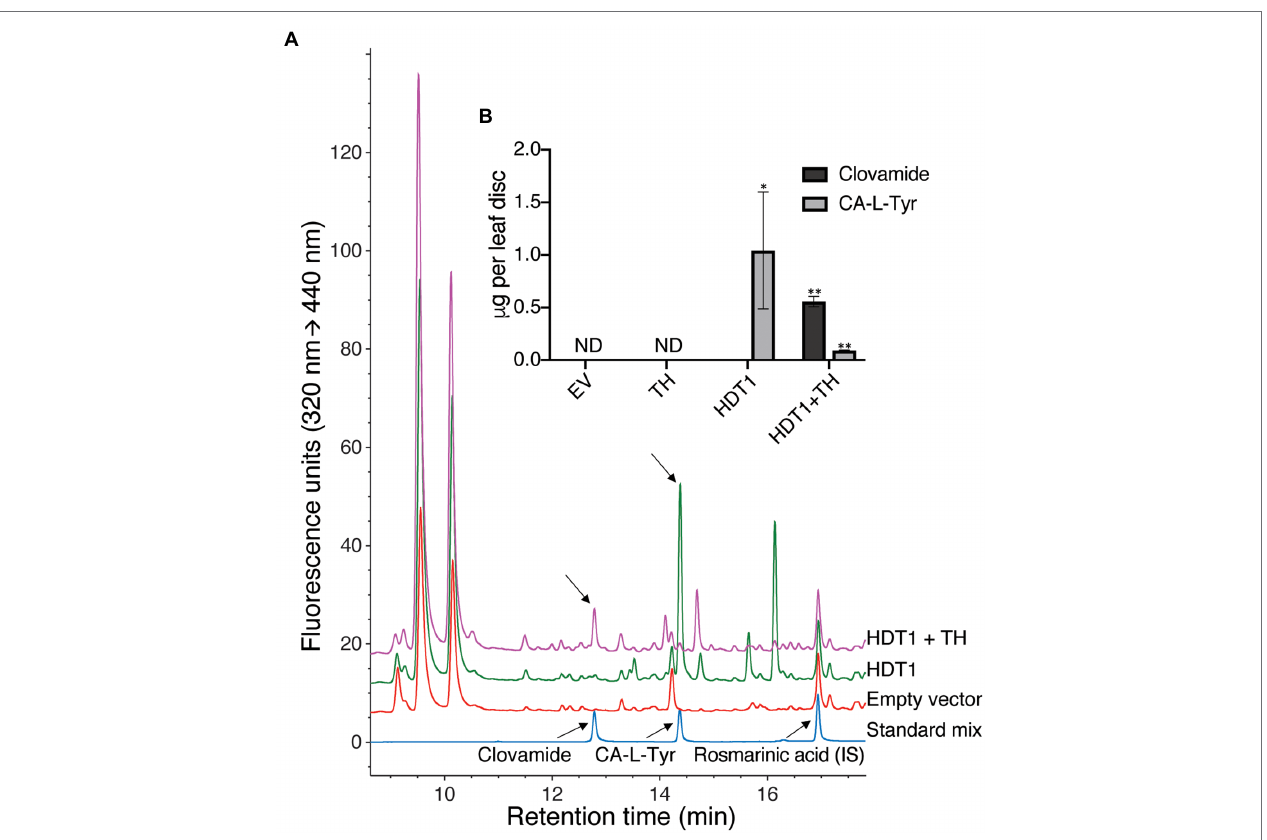
FIGURE 6 | Formation of clovamide in Nicotiana benthamiana leaf by A. tumefaciens- mediated transient coexpression of HDT1 with beet tyrosine hydroxylase (TH, CYP76AD6). (A) HPLC-FLD chromatograms of N. benthamiana extracts and standards (IS, internal standard). (B) Clovamide and caffeoyl-L - tyrosine (CA-L-Tyr) quantification in N. benthamiana extracts resulting from transient expression of the empty vector control (EV), tyrosine hydroxylase (TH), HDT1, or coexpression of HDT1 and tyrosine hydroxylase (HDT1 + TH). Mean ± SE, n = 4 except for HDT1 + TH ( n = 3), ND = not detected. p < 0.11 (*) and p < 0.01 (**) using student’s t-test, in comparison with the empty vector control